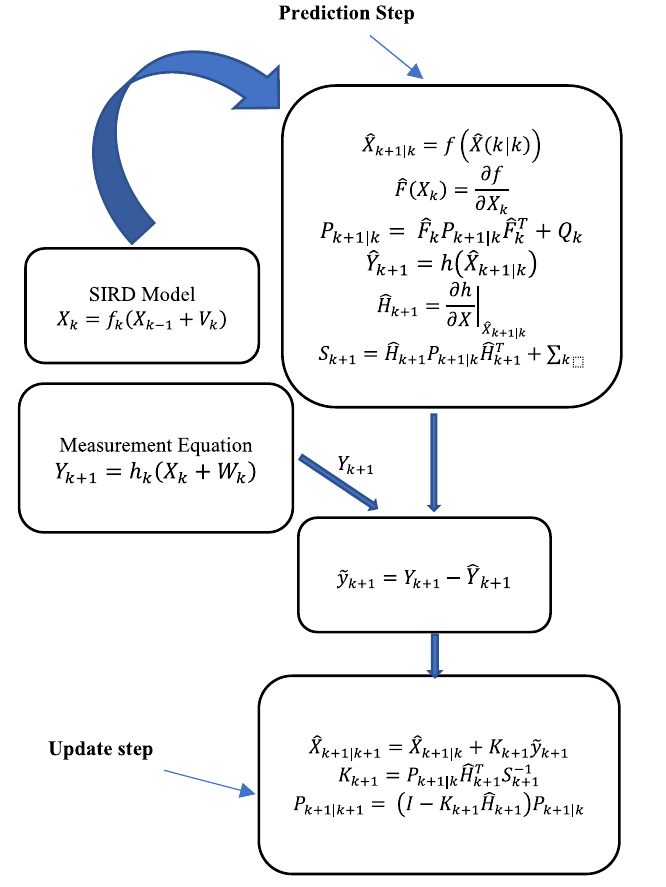
Figure 2. EKF-SIRD Model